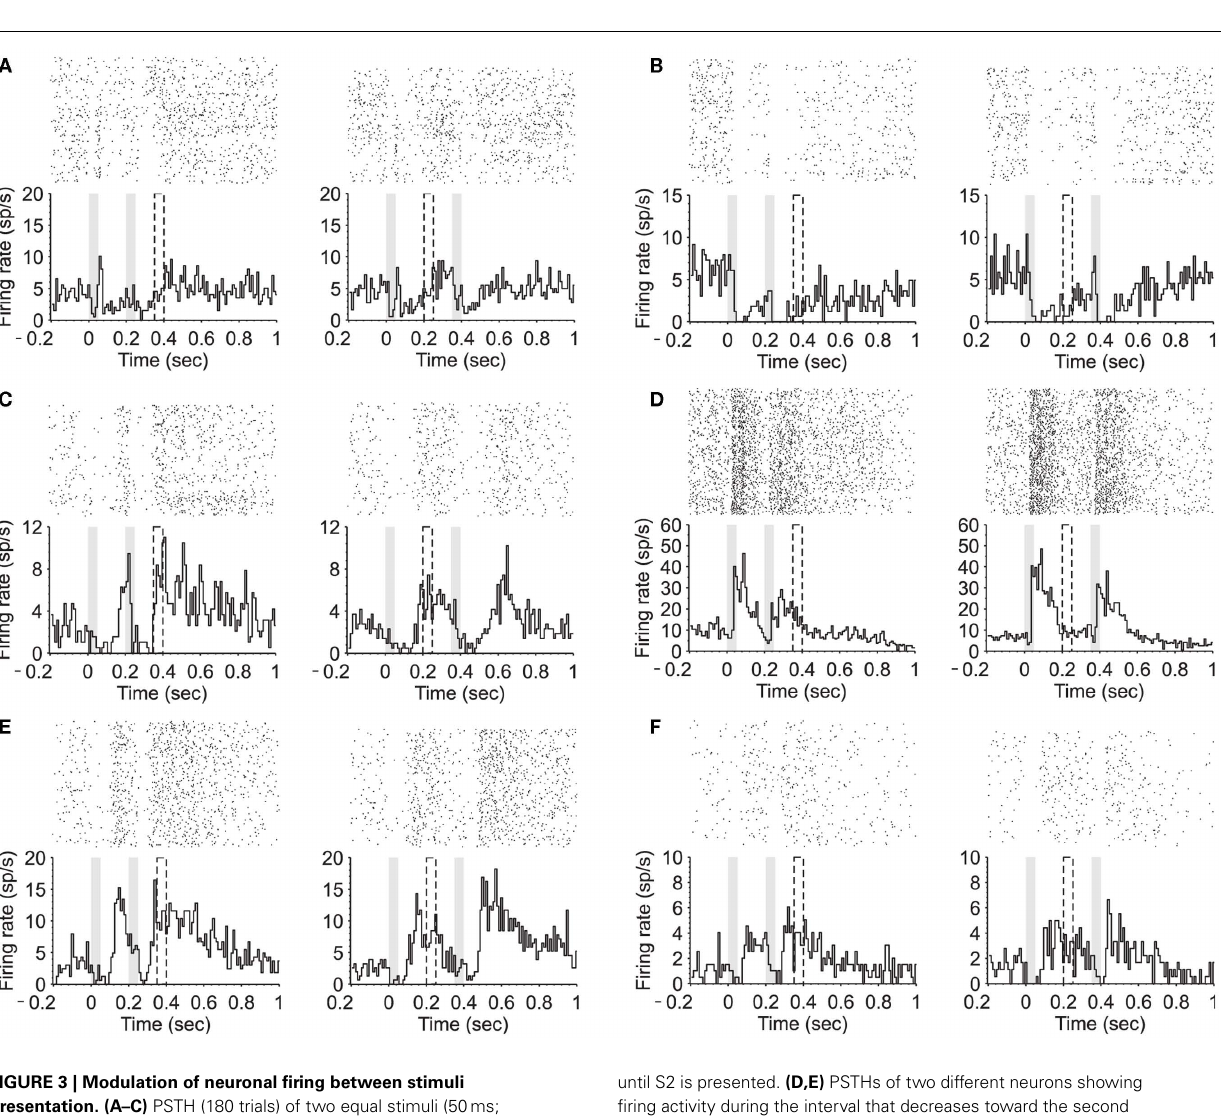
until S2 is presented. (D,E) PSTHs of two different neurons showing firing activity during the interval that decreases toward the second stimulus. (F) PSTH of an example neuron showing a late onset response accompanied by a sustained activity after stimuli